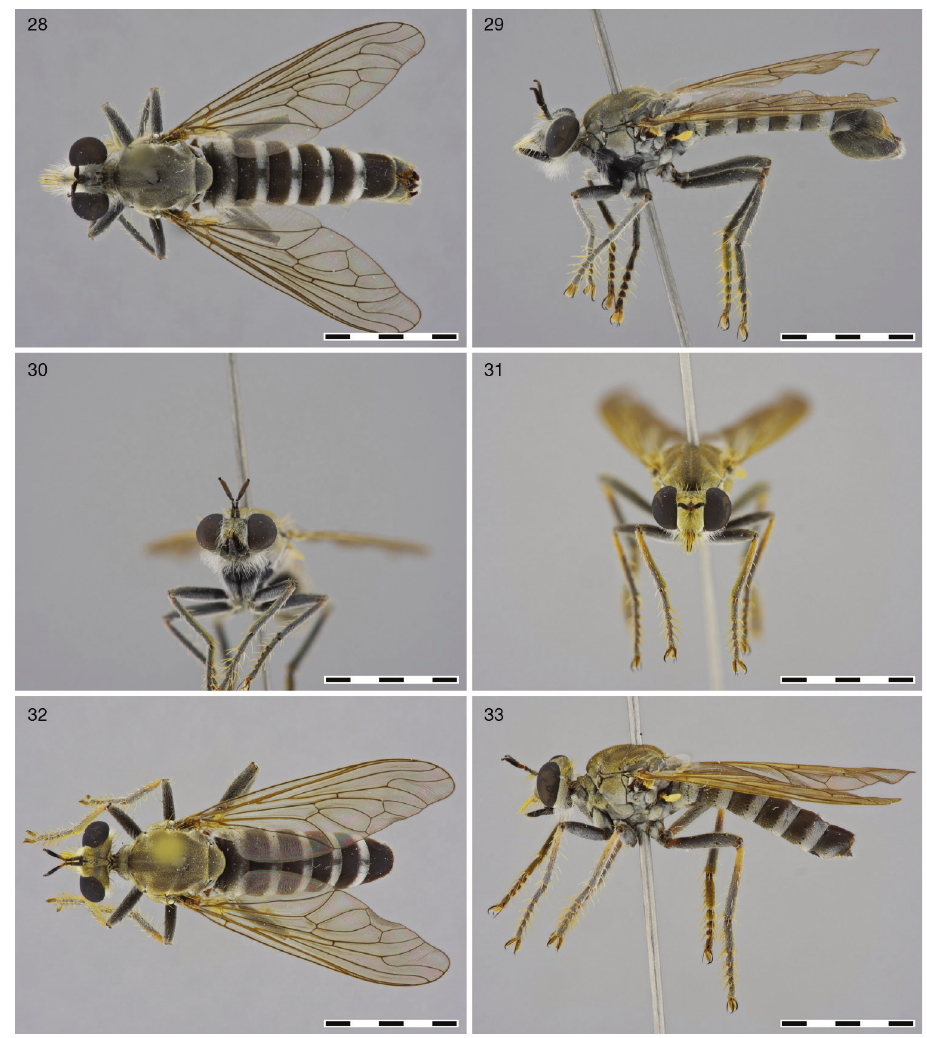
Figures 28–33. Laphyctis eremia sp. n.: ♂ (USNMENT00832217) 28 dorsal (Morphbank #861199) 29 same, lateral (#861201) 30 same, head anterior (#861203), ♀ (USNMENT00832224) 31 head ante- rior (#861195) 32 same, dorsal (#861191) 33 same, lateral (#861193). Scale = 5 mm.